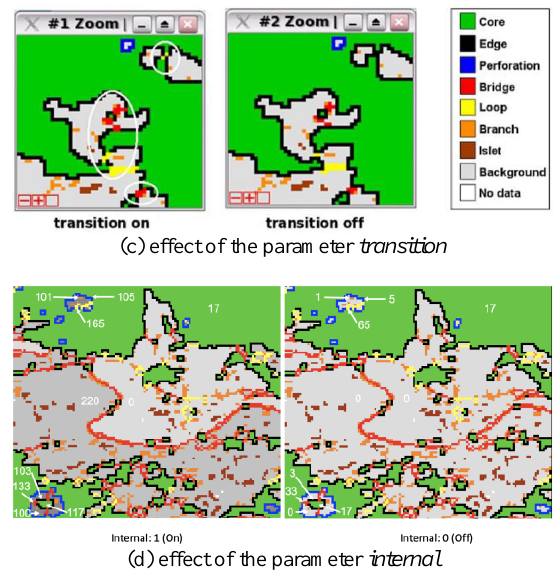
Figure 2 . The 4 MSPA input numerical parameters and their impact on the resulting